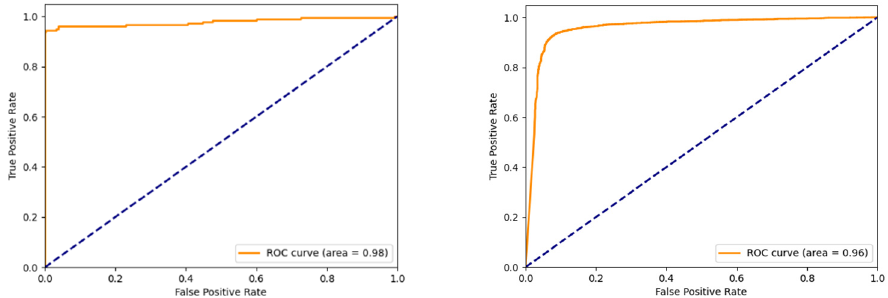
Figure 8. ROC-AUC curve. The left side is the curve of Celeb-DF v2 validation set, the right side is the curve of DFDC validation set.